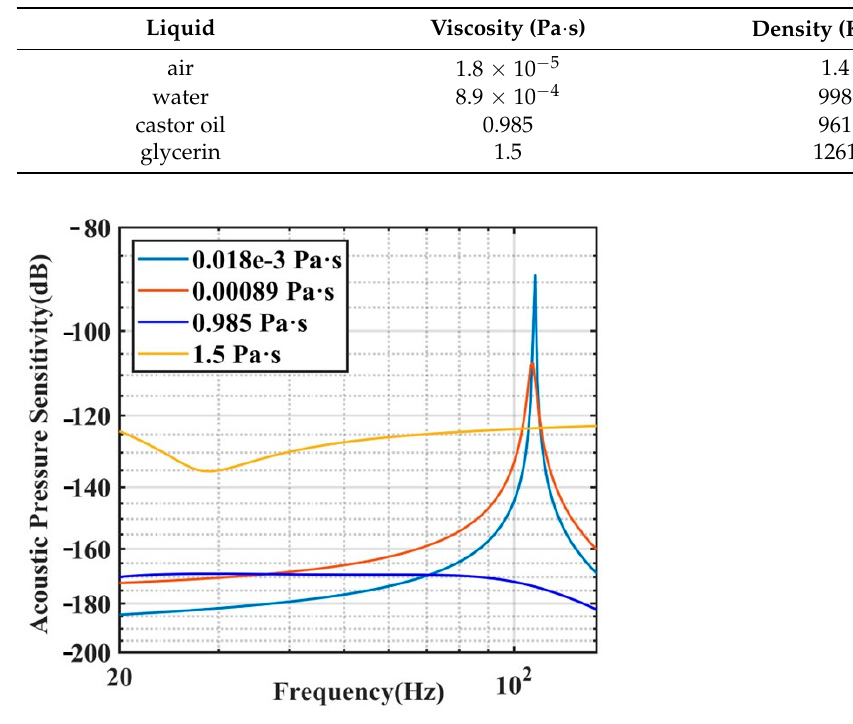
Figure 6. The setup of the aluminum support on the shaker.